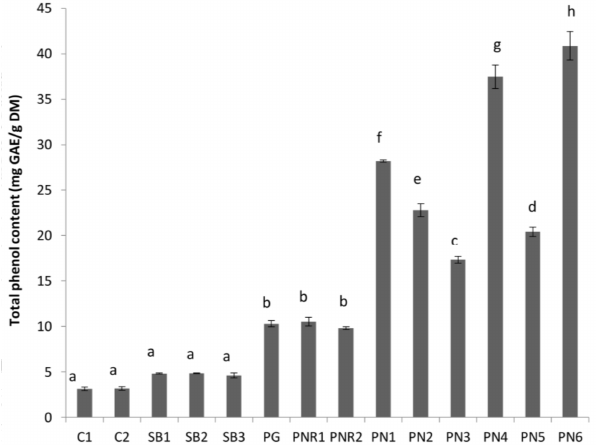
Figure 2. Total phenol content in mg gallic acid equivalents (GAE) per gram of dry lees (mg GAE/g FDM) of different wine lees extracts investigated in the present study. Treatments do not share the same letter (a–h) are significantly different ( p < 0.05). Error bars are the standard deviation of replicate